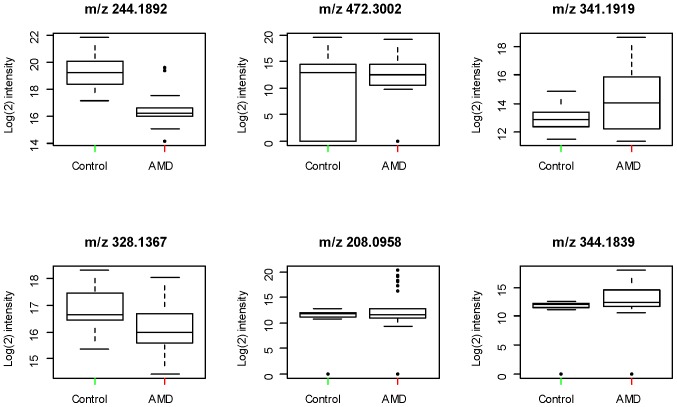
Box-and-whisker plots of selected features comparing the mean and standard error for cases and controls.Plots were examined for each of the 94 features.